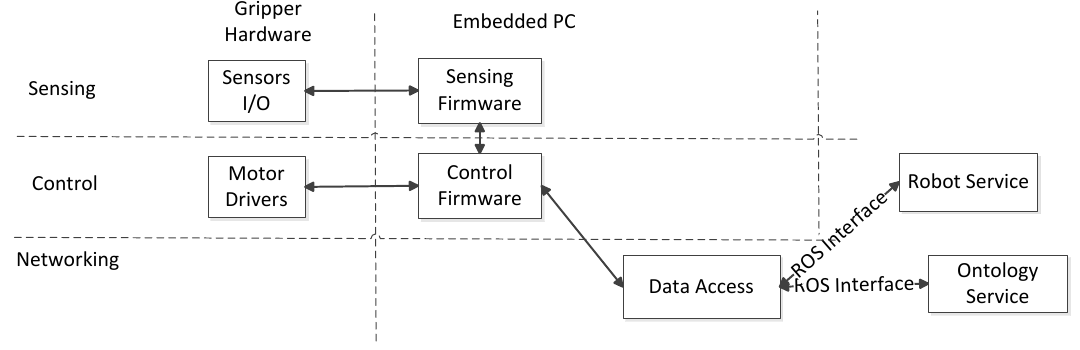
Figure 4. Gripper agent architecture.